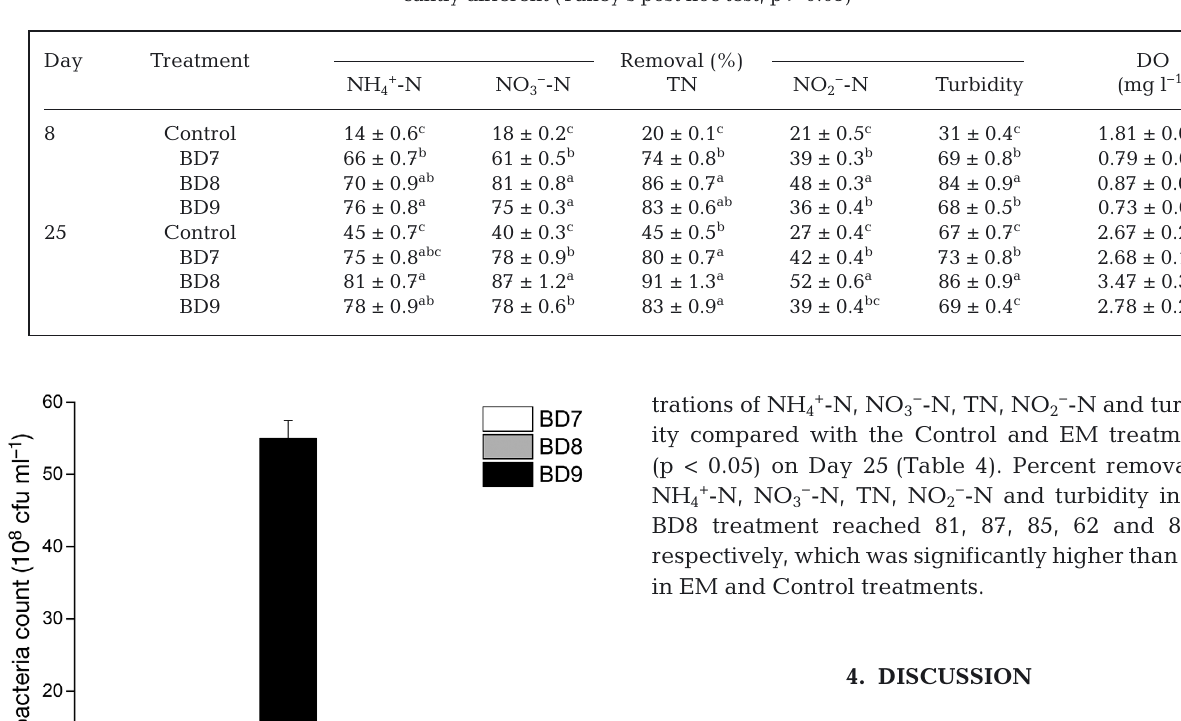
Table 1. Effect of Bacillus subtilis D9 inoculum on the removal of nitrogenous pollutants, turbidity and dissolved oxygen (DO) concentration in wastewater after 8 and 25 d. Data are means ± SD. BD7/BD8/BD9: inoculation levels of B. subtilis D9 at 5.5 ×